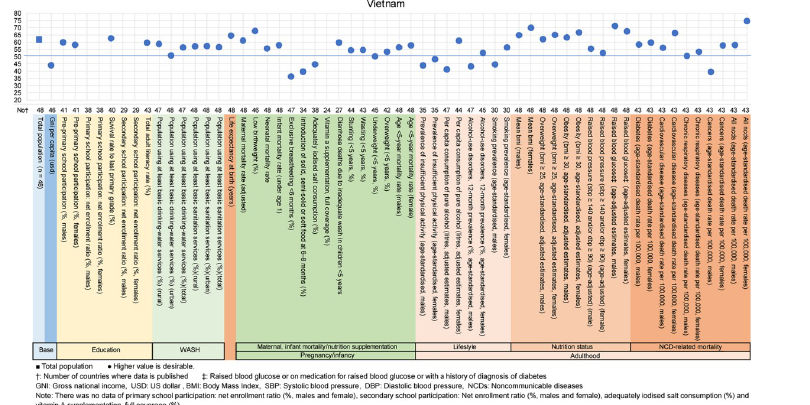
Fig 5. Country diagnosis by the deviation graph for Vietnam.